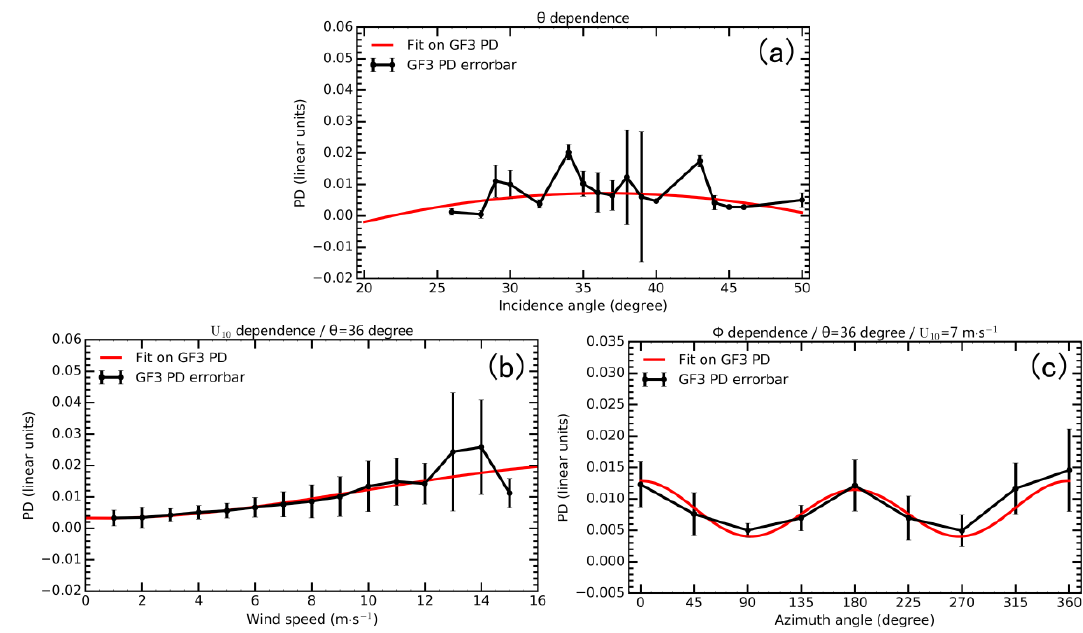
Figure 17. The GF-3 polarization difference dependence on ( a ) incidence angle, ( b ) wind speed, and ( c ) azimuth angle. The GF-3 NRCS data are